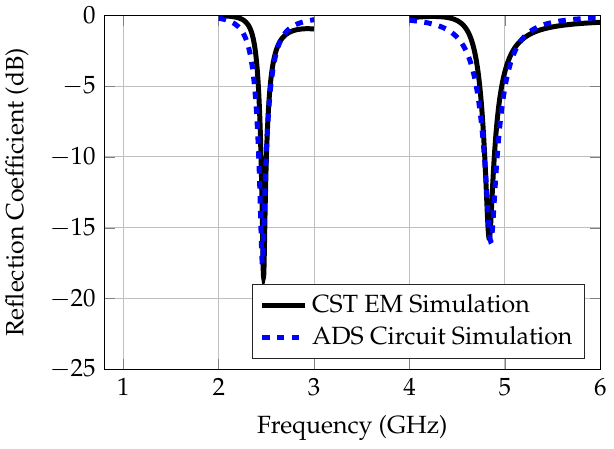
Figure 4. Circuit simulation vs. EM